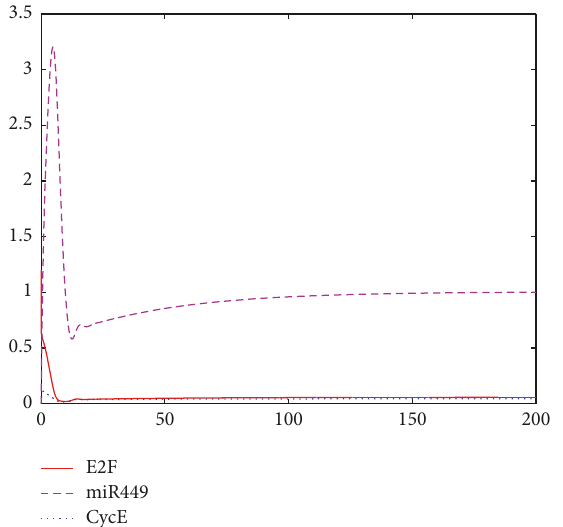
Figure 7: An asymptotically stable equilibrium for 𝜏 = 𝜏 1 = 𝜏 2 = 𝜏 < 𝜏 3 0 . Assume initial conditions are 0, 𝑥 = 0, 𝑥 = 0, 𝑥 = 0.55, 𝑥 4 5 6